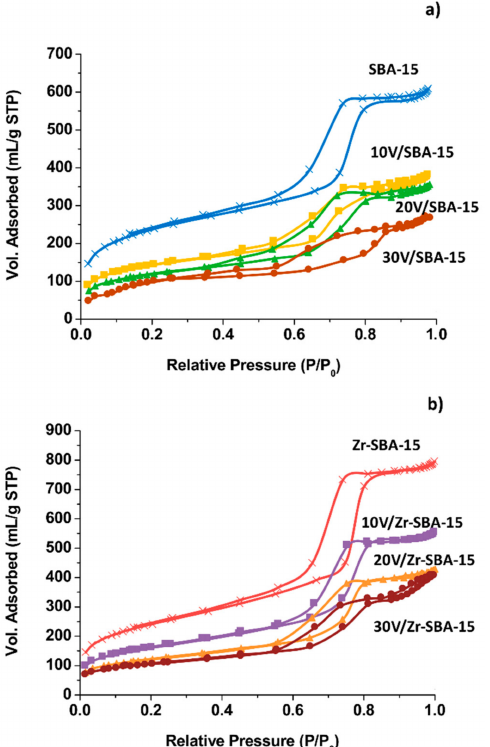
Figure 2. Features of nitrogen adsorption-desorption isotherms. ( a ) SBA-15 and V 2 O 5 /SBA-15;